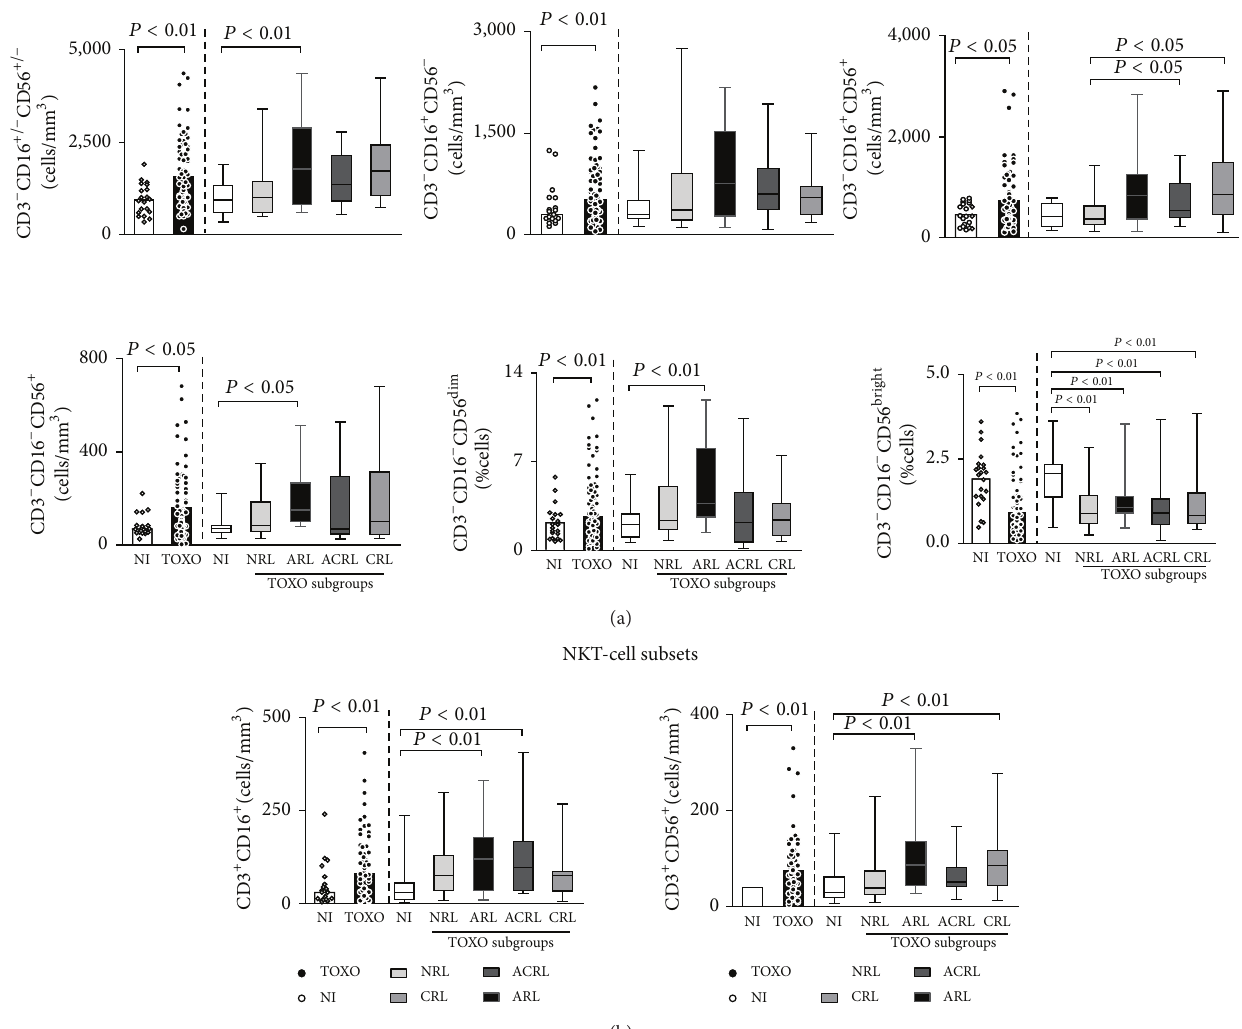
Figure 2: NK- (a) and NKT-cell subsets (b) in the peripheral blood of congenital toxoplasmosis infants (TOXO) and noninfected controls (NI). Congenital toxoplasmosis was further categorized according to the clinical ocular status, referred to as no retinochoroidal lesions (NRL), active retinochoroidal lesions (ARL), active/cicatricial retinochoroidal lesions (ACRL), and cicatricial retinochoroidal lesions (CRL). The results are expressed as scatter plots of individual values and the medians of absolute cell counts/mm 3 (left side) or in box-plot format (right side), where the box stretches from the lower hinge (25th percentile) to the upper hinge (75th percentile), and the middle half represents the median of the distribution as a line across the box. Significant differences are highlighted by connecting lines, and 𝑃 values are shown in the